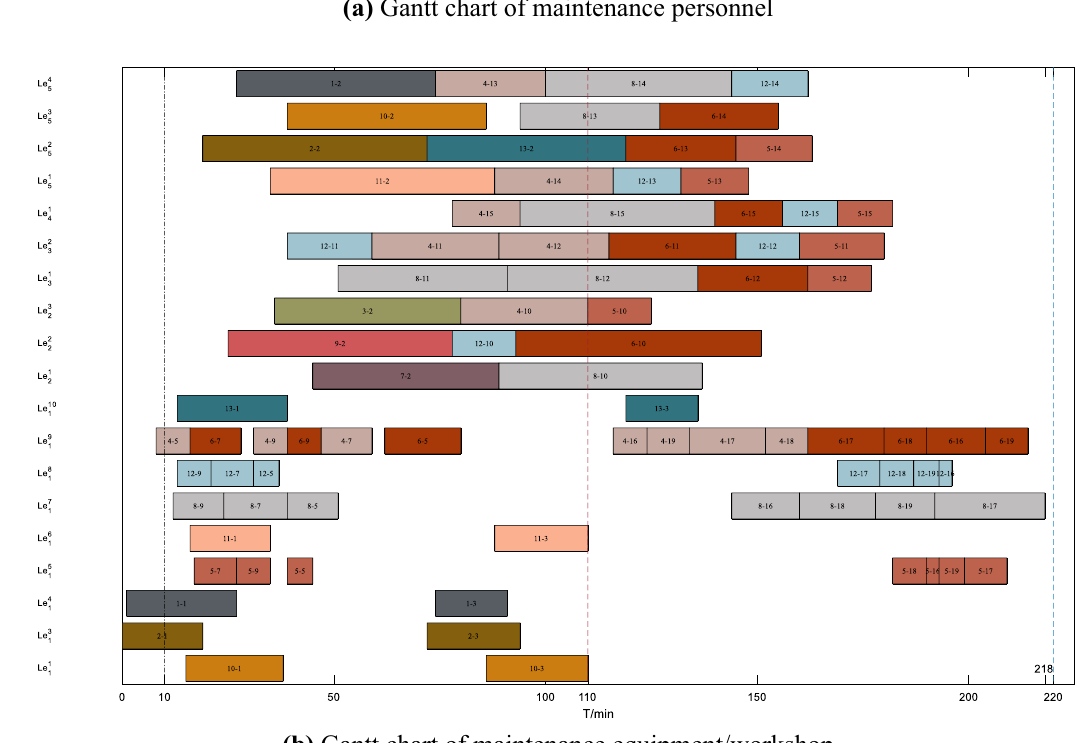
providing the best rescheduling solution in real time, the task is guaranteed to proceed